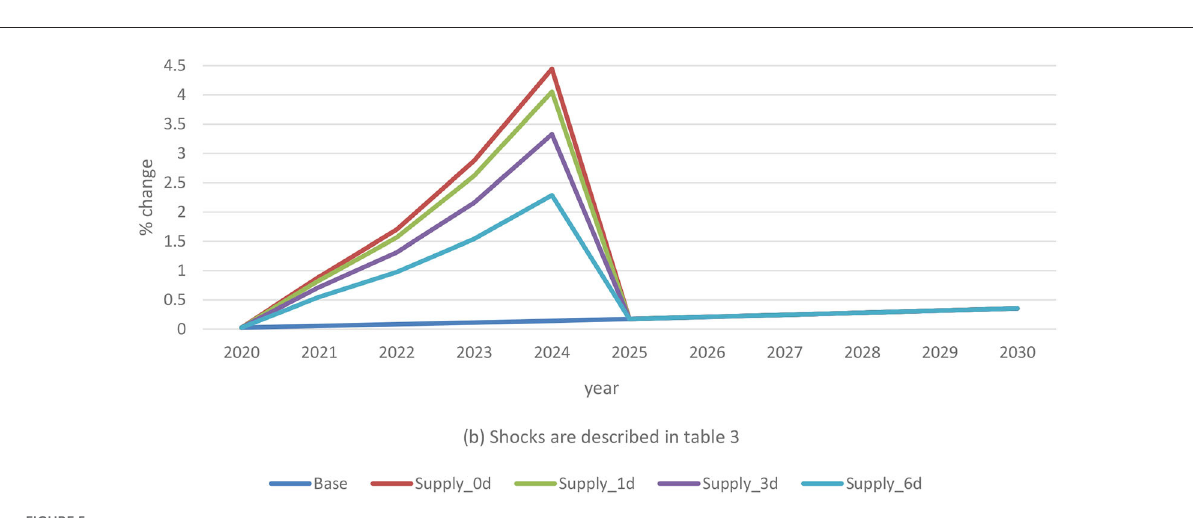
FIGURE5 Commercial pig price changes in combined scenarios. (b) Shocks are described in Table 3.